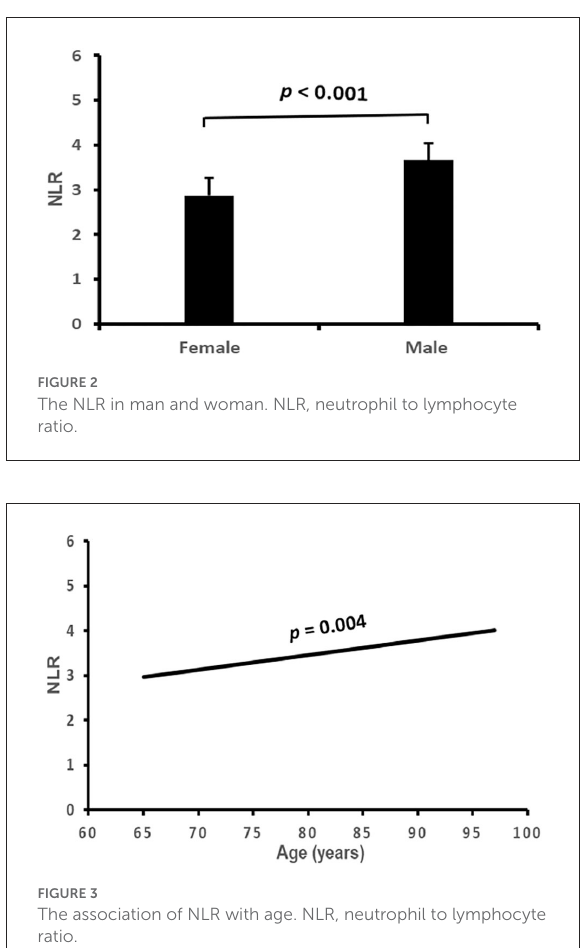
marker NLR in elderly MetS. This finding is consistent